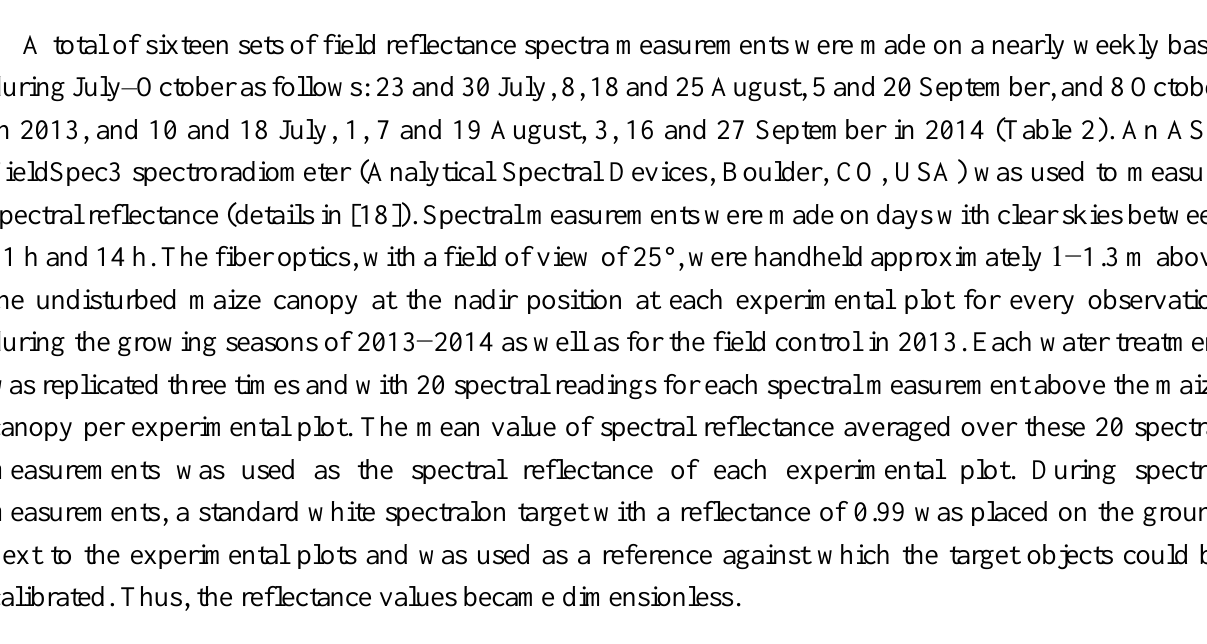
Table 2. Field reflectance spectra measurement dates in 2013 and